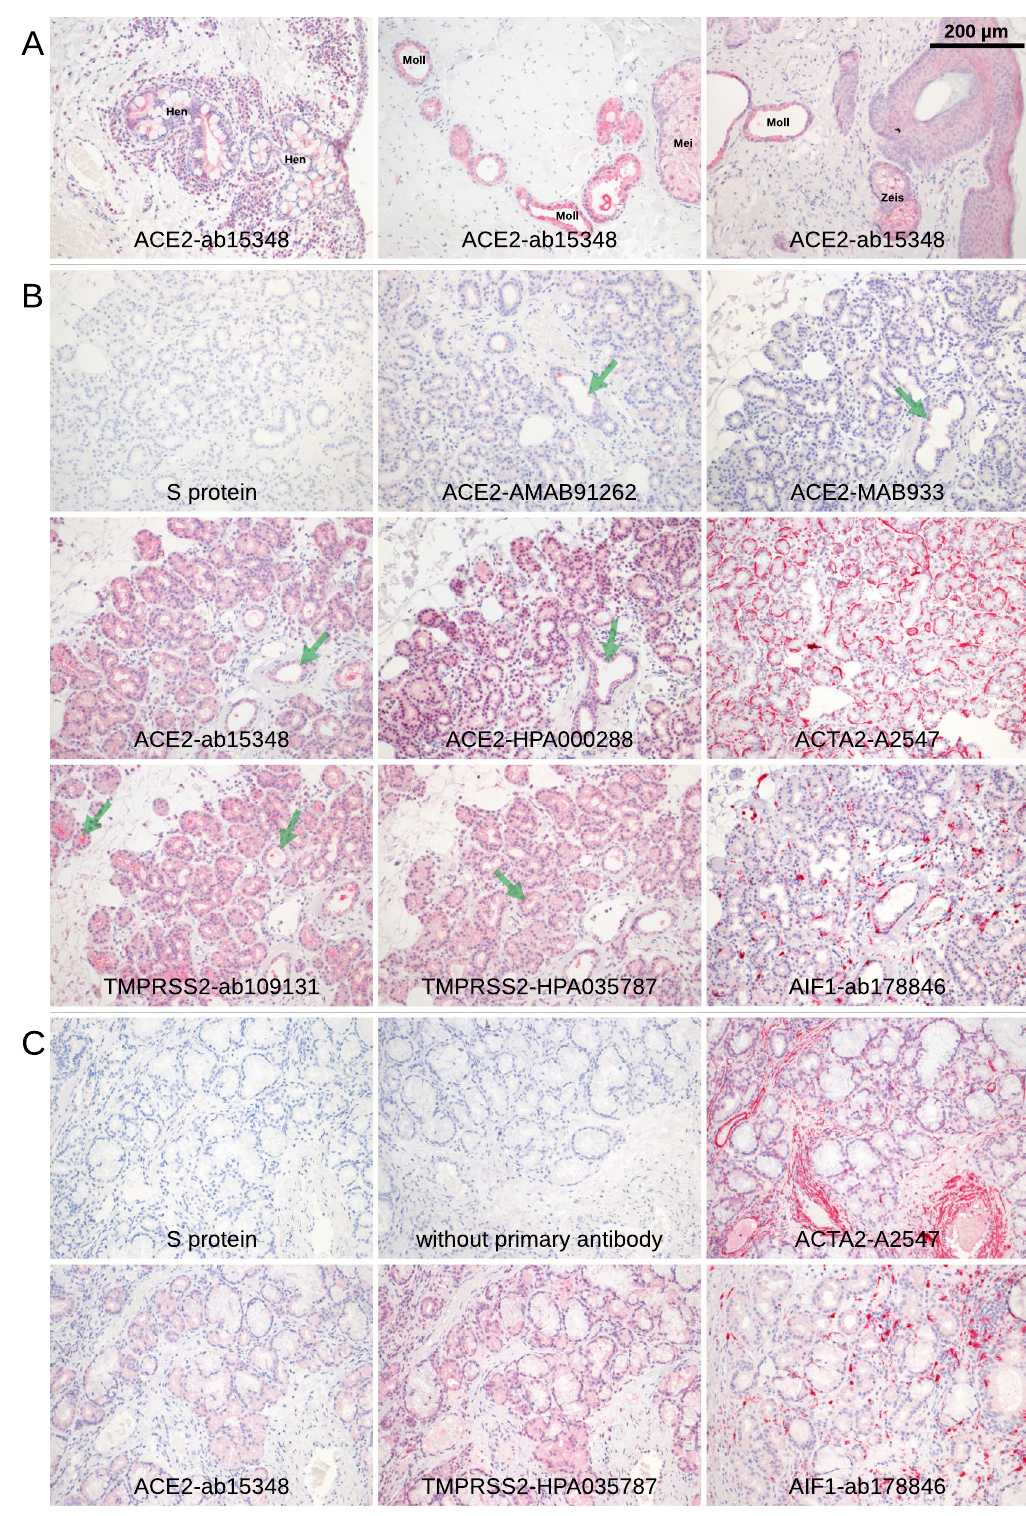
Figure 5. Eye lid, lacrimal gland, nose. Staining of serial paraffin sections (red). ( A ) The antibodies targeting ACE2 showed a week staining in the Meibomian glands (Mei), the Henle’s crypts (Hen) in the tarsal region, the Moll glands, and the Zeis sebaceous glands near the hair follicle. In all glands, there was a weak staining in the glandular epithelium that was more intense on the secretory side of the cells and thus adjacent to the glandular lumina. In addition, staining intensity increased in the distal parts of the tubes. ( B ) The lacrimal gland showed no staining for S protein or rarely some staining restricted to small areas. Week staining of the glandular tissue was found when stained with the antibodies, and it was also found with antibodies targeting ACTA2 and AIF1 indicating background. In contrast, a stronger, rather specific staining was at the luminal side of the glandular epithelium (green arrows). ( C ) Subepithelial glands within the skin of the nasal cavity showed staining for ACE2 and TMPRSS2 while S protein was negative. Staining for ACTA2 and AIF1 showed the same weak staining of the glands so that this staining is background rather than